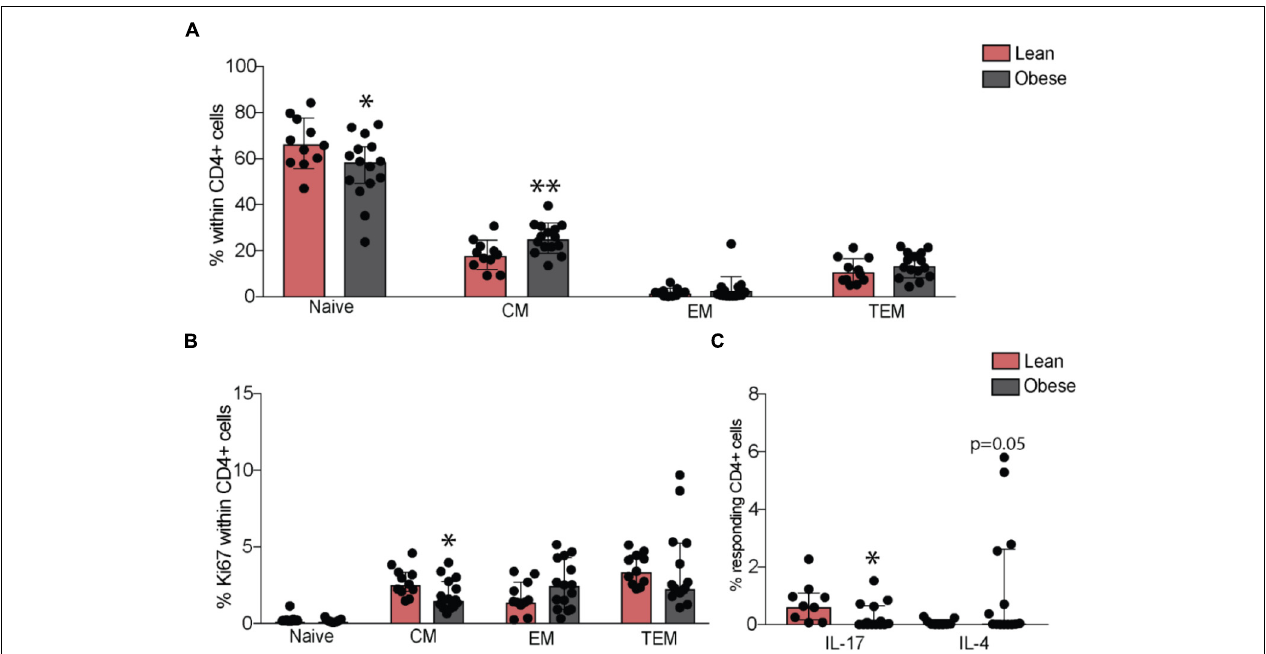
FIGURE 2 | Pregravid obesity alters frequencies of circulating CD4+ T-cells and their responses to stimulation. (A) Changes in percentages of circulating naïve and memory CD4+ T-cells subsets measured by flow cytometry and (B) their homeostatic proliferation. (C) Changes in frequency of IL17 and IL4 secreting CD4+ T-cells following in vitro CD3/CD28 activation. Significant differences between groups are indicated as follows: ∗ p < 0.05, ∗∗ p < 0.01, ∗∗∗ p < 0.001, and ∗∗∗∗ p < 0.0001. All of the bar graphs show median values with interquartile ranges